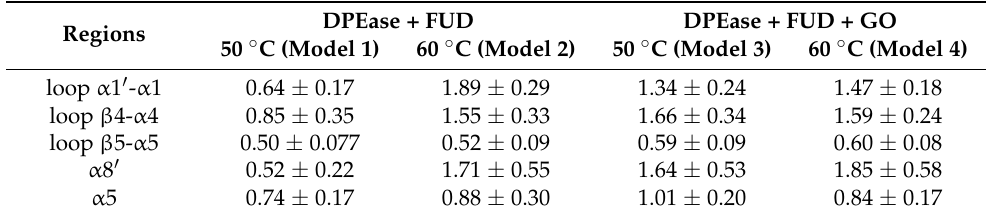
Table 1. Average backbone atoms RMSD of loop α 1 (cid:48) - α , loop β 4- α 4, loop β 5- α 5, α 8 (cid:48) , and α 5 through-